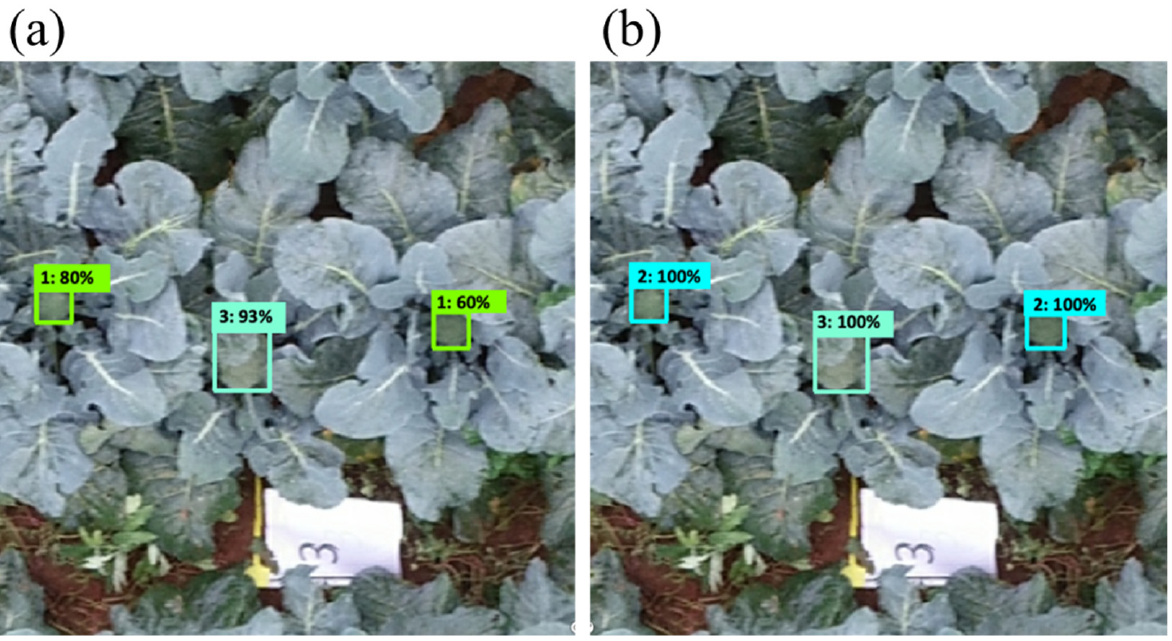
Figure 11. Examples of ( a ) broccoli head detections and ( b ) ground truth labels using the three-class approach.